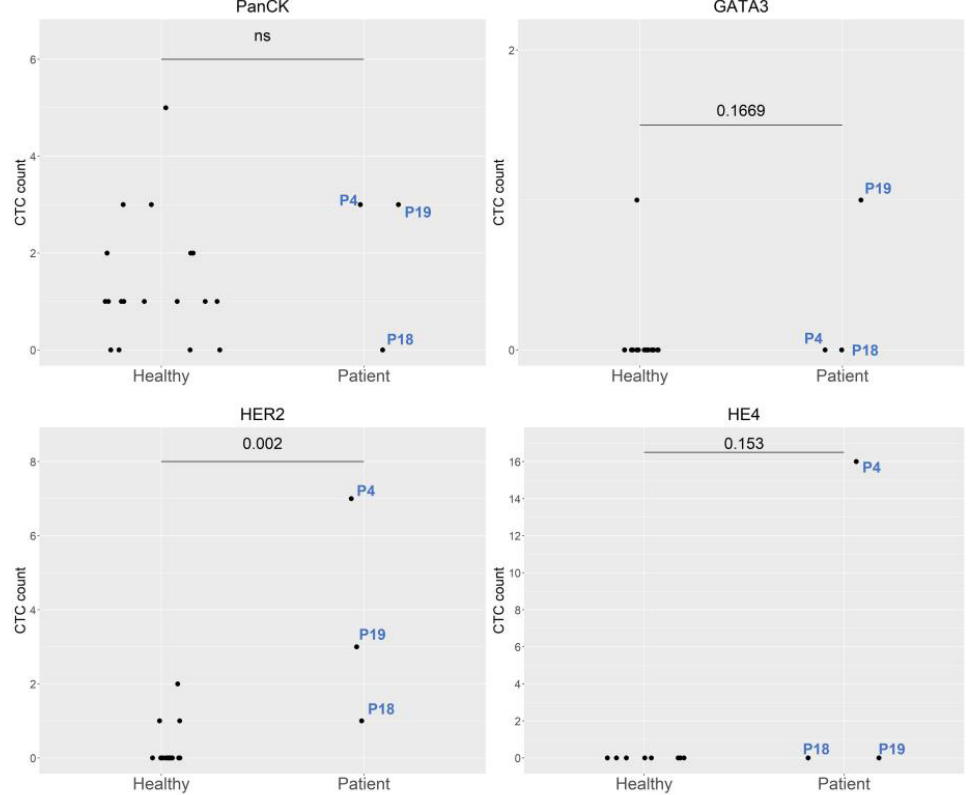
Figure 1. Comparison of molecular expression between healthy controls and cervical cancer patients. Abbreviations: P4, Patient 4; P18, Patient 18; and P19, Patient 19.